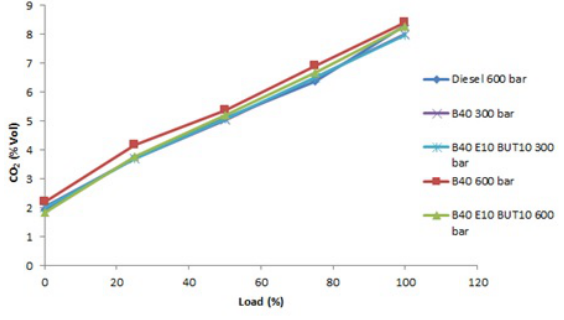
Fig. 3. Various BTE with Engine Load. Fig. 4. Various carbon dioxide with Engine Load.